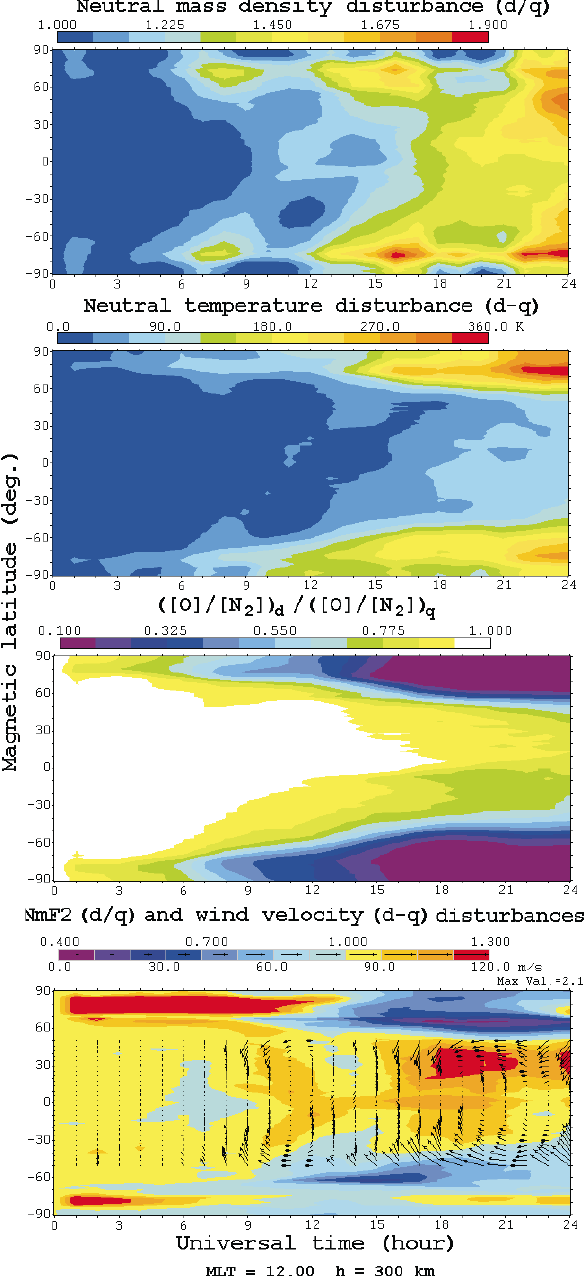
Fig. 8. The storm time evolution of the neutral mass density disturbance (storm to quiet density ratio, upper panel ) and of the neutral temperature disturbance (storm minus quiet temperature, K, second panel ) for 1200 MLT at an altitude of 300 km. The third panel shows similarly to Fig. 4 the temporal development of the neutral composition disturbance (storm to quiet ratio of [O]/[N ]), while the 2 bottom panel presents the electron density disturbance at the F -layer 2 maximum ( N F , storm to quiet density ratio) at the background of m 2 the horizontal thermospheric wind disturbance (storm minus quiet velocity, m/s) for magnetic latitudes <50 (cid:176) only for clarity reasons. The arrow length indicates the wind amplitude as shown in the